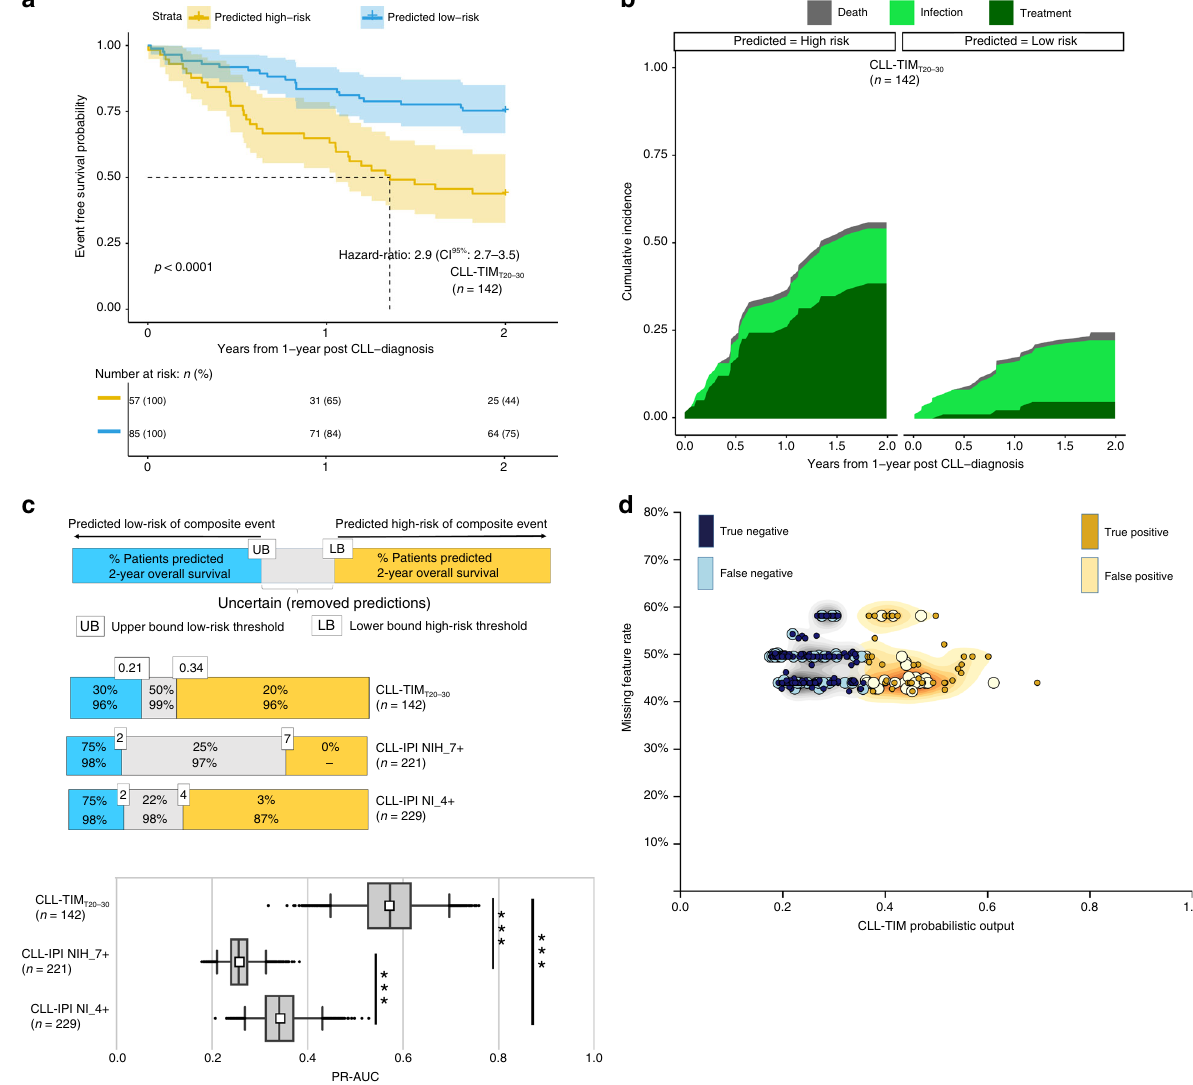
Fig. 4 CLL-TIM is robust to missing data on external test cohort. a Kaplan – Meier graphs of infection-free, CLL treatment-free survival for CLL-TIM T20-30 predicted high-risk and low-risk groups on a subset of the external test cohort (BENCH-E, n = 281 with n = 142 high-con fi dence predictions). Patients in BENCH-E have full CLL-IPI and a full 2-year follow-up. P -value is by log-rank test. b Cumulative incidence plots for CLL-TIM T20-30 predicted high-risk and low-risk groups for CLL treatment (dark green), infection (bright green) and death (gray) as fi rst events on BENCH-E. c Two-year outcome PR-AUC (Precision-Recall Area-Under-Curve) for CLL-TIM and CLL-IPI on BENCH-E. To allow for an equitable comparison, CLL-TIM T20-30 (i.e. with removal of uncertain predictions) was benchmarked against an additional two versions of CLL-IPI score; CLL-IPI with removal of patients in the intermediate-risk category, CLL-IPI NI_4 + , and CLL-IPI with removal of the intermediate and high-risk category, CLL-IPI NIH_7 + . For box-and-whisker plots, whiskers are 95% con fi dence intervals generated using 5000 bootstrapped datasets sampled from each respective cohort (See Methods), white square is the mean, centre line is the median, bounds of box are the interquartile range and black dots are outliers. We performed model comparison using a one-tailed Mann – Whitney U-test on the mean difference of the PR-AUC over the bootstrapped datasets. *** indicate p < 0.0005. d Average missing feature rate for patients in external test cohort. Shaded distributions are blue – low-risk high-con fi dence predictions, gray – low-con fi dence predictions, gold – high- con fi dence high-risk predictions. Missing feature rate is the percentage of CLL-TIM ’ s 228 features that were missing for the given patient. Data shown for CLL-TIM ’ s predictions on the external German test cohort ( n = laboratory test variables (Supplementary Fig. 9). Baseline variables Fig. 10c). Extracting the top 20% high-risk, and top 30% low-risk were all available except for del(13q). This resulted in an average patients (T 20 – 30 , Methods subsection Clinical trial requirements), CLL-TIM T 20 – 30 achieved a 2-year EFS of 43.9 and 75.3%, for missing feature rate ranging from 42 to 58% per base-learner; while the cohort overall had indolent baseline characteristics with those patients predicted as high-risk and low-risk, respectively half of the high-risk patients randomized for early treatment and (CI 95% : 32.7 – 58.8% and 66.7 – 85.0%; Fig. 4a – c and Supplementary thus removed prior to this analysis (Table 1). For comparison to Table 12). Under these substantial missing data conditions, per- CLL-IPI and BENCH-I, we considered 281 patients with a full formance was still signi fi cantly better than CLL-IPI based on PR- CLL-IPI and a full 2-year follow-up (BENCH-E; Supplementary AUC (Fig. 3c) and MCC (Supplementary Tables 13 – 18).